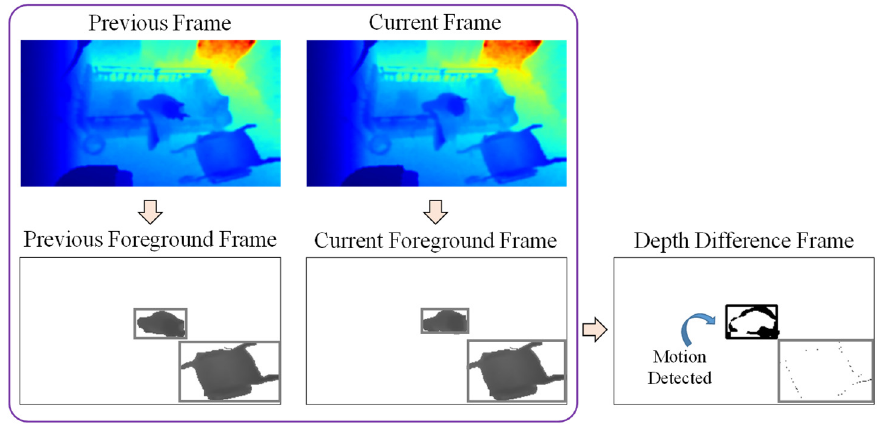
Figure 10. Example of motion detection for an elderly person sitting on the bed.